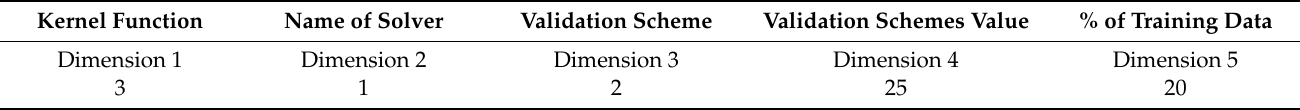
Table 3. Moth’s representation.